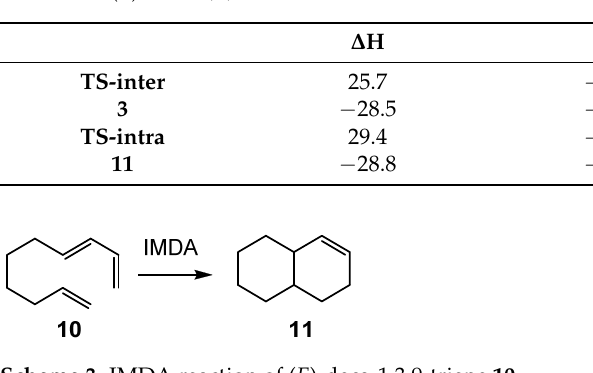
Table 1. B3LYP/6-311G(d,p) relative enthalpies ( Δ H, in kcal·mol − 1 ), entropies ( Δ S, in cal·mol − 1 ·K) and Gibbs free energies ( Δ G, in kcal·mol − 1 ) computed at 165 °C and 1 atm of the stationary points involved in the intermolecular N-DA reaction of butadiene 1 and ethylene 2 , and in the IMDA reaction of ( E )-deca-1,3,9-triene 10